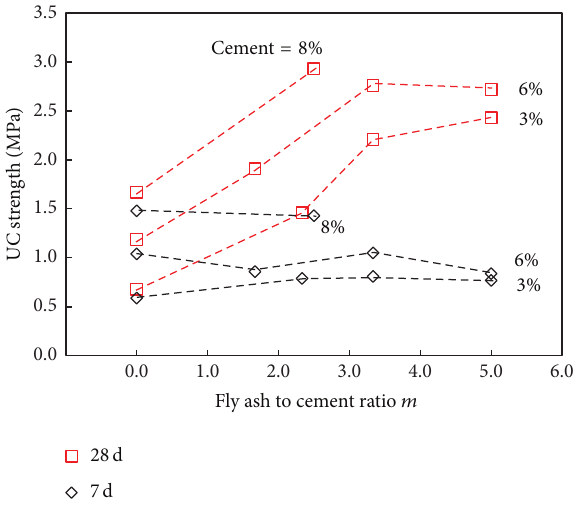
Figure 5: UC strength versus fly ash to cement mass ratio. values (1.3 to 2.2 MPa) dependent on the fly ash contents.